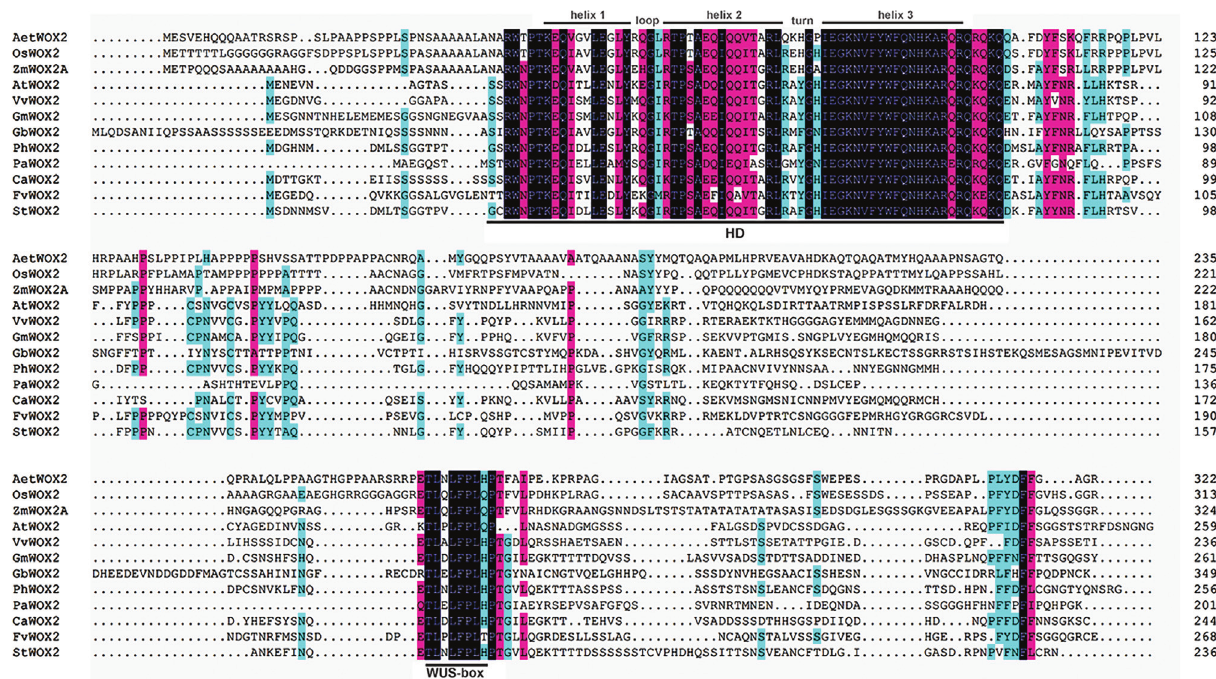
Figure2 -MultiplesequencealignmentofWOX2.AbbreviationsareG.biloba,Gb; G.max ,Gm; V.vinifera ,Vv; Petuniaxhybrida ,Ph; S.tuberosum ,St; C. arietinum , Ca; F. vesca , Fv; and P. abies , Pa.